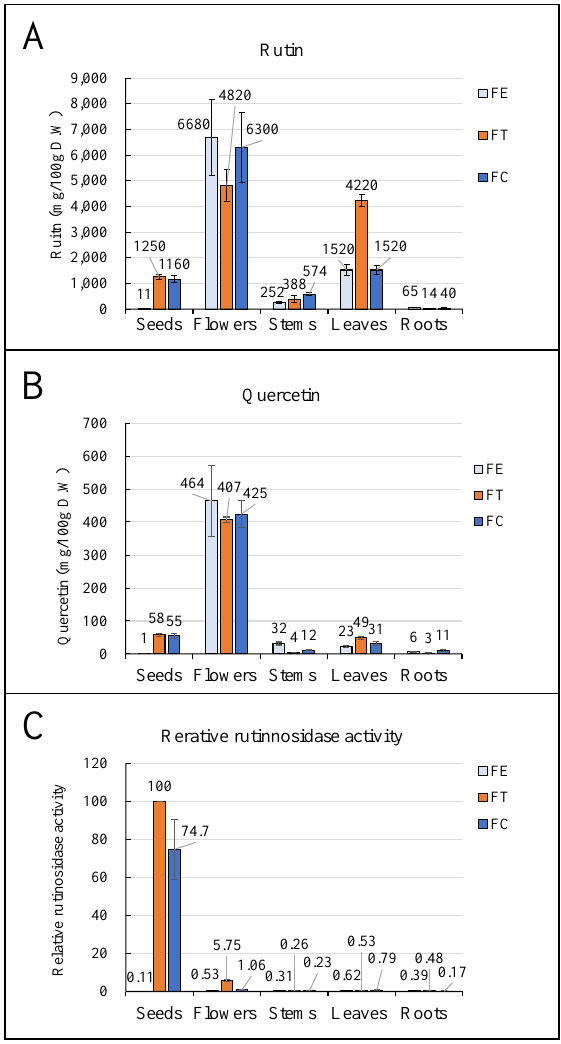
Figure 1. Rutin and quercetin concentration and Rutinosidase activity in different organs in FE, FC, and FT. Rutin (A) and quercetin (B) concentrations were evaluated using UPLC. To investigate the in vitro rutinosidase activity (C), a standard assay was performed by measuring the quercetin con- centration in the reaction mixture using UPLC. Data represent the mean of independent experiments ( n = 3). Bars indicate SD.